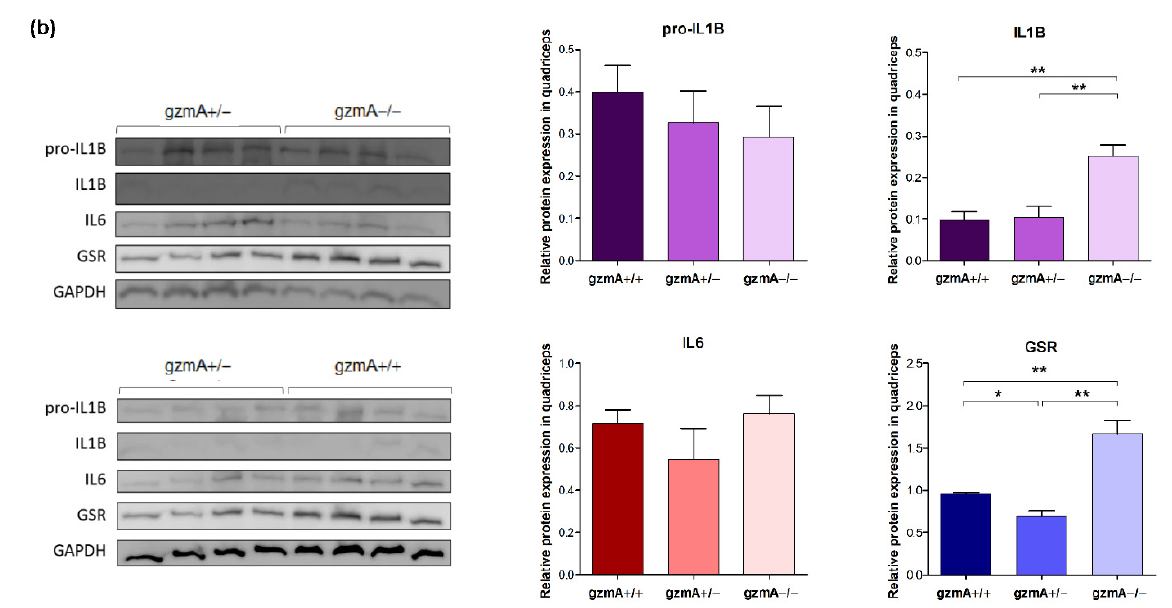
Figure 5. IL1B, IL6 and GSR protein expression in spinal cord ( a ) and quadriceps ( b ) from SOD1G93A mice from the survival assay. IL1B, IL6 and GSR protein expression was analyzed in spinal cord and quadriceps of 12 SOD1+/ − mice, including gzmA+/+( n = 4), gzmA+/ − ( n = 4) and gzmA − / − ( n = 4) mice. GSR was found at lower levels in hemizygous mice compared to both homozygous mice. Levels of IL6 in spinal cord and IL1B in quadriceps were reduced in gzmA+/+ and gzmA+/ − mice. ** p < 0.01, * p < 0.05.